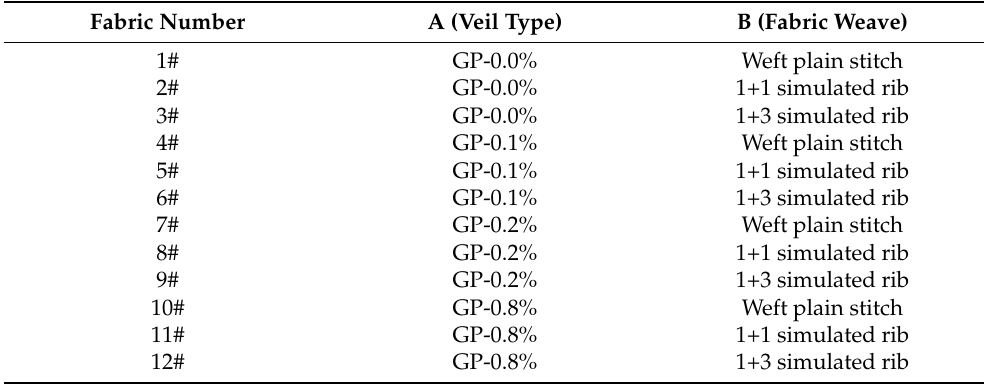
Table 2. Sample scheme sheet.